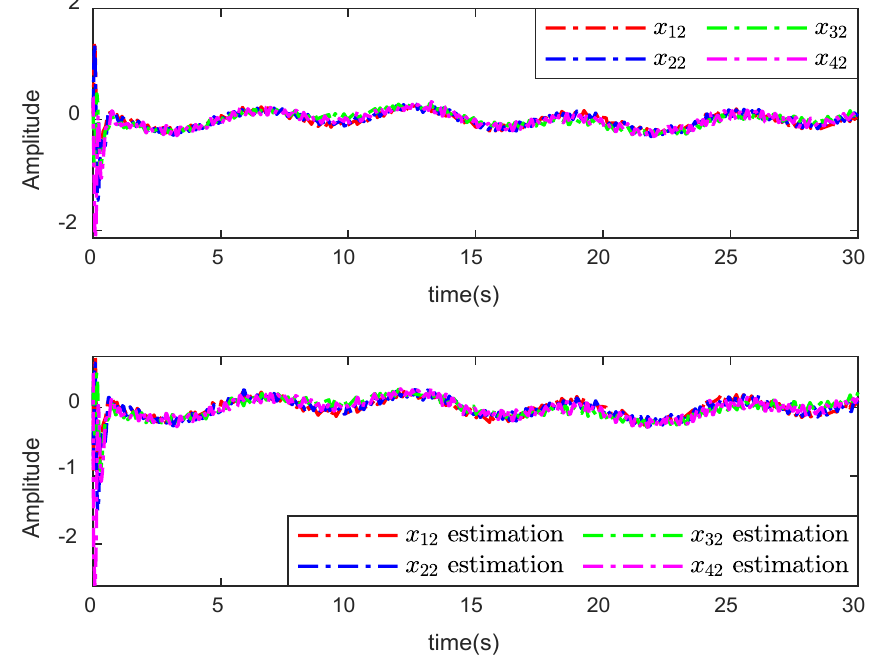
Figure 6. The trajectories of the x i ,2 ( i = 1, · · · ,4 ) and x i ,2 ( i = 1, · · · ,4 ) estimation